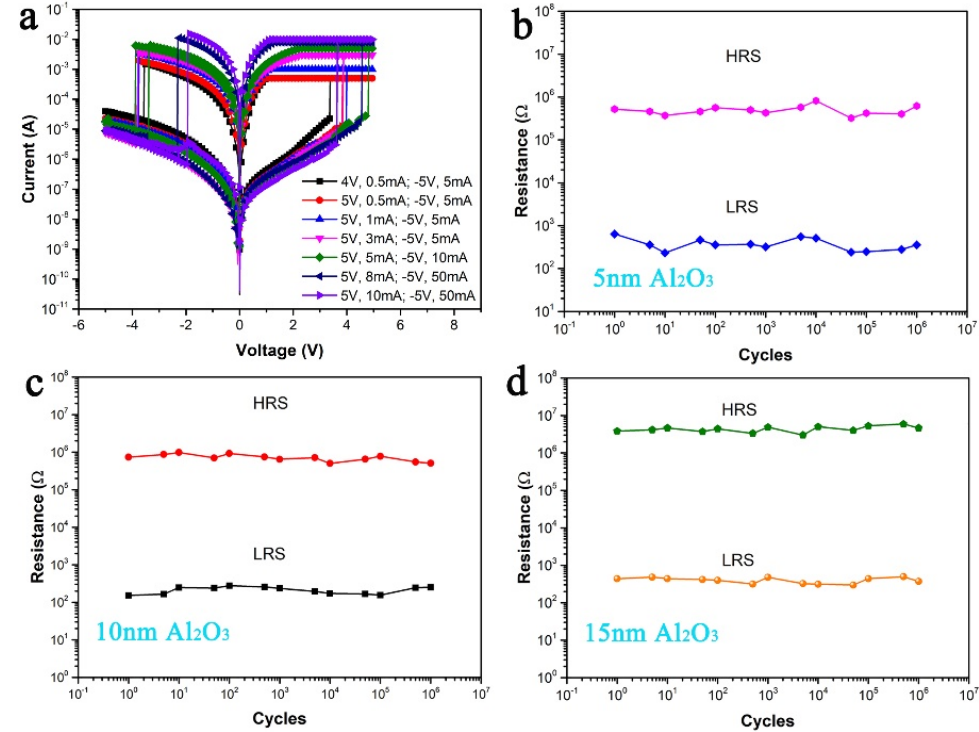
Figure 2. The multi-level state ( a ) of the Cu/Al 2 O 3 (10 nm)/Cu devices. The endurance of devices with 5 nm ( b ), 10 nm ( c ), and 15 nm ( d ) Al 2 O 3 .